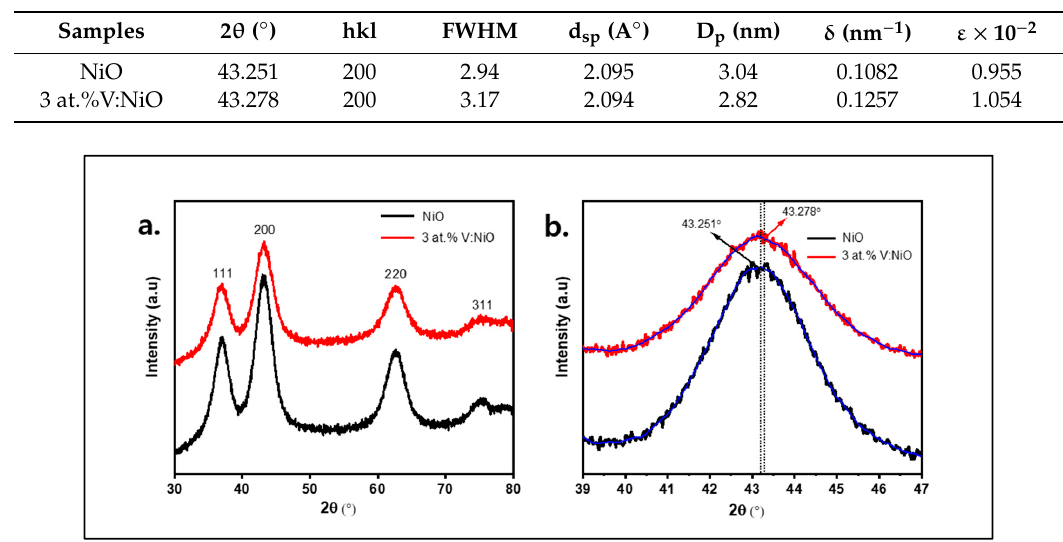
Figure 1. ( a ) XRD spectra of pristine and 3 at.%V:NiO nanoparticles (NPs) and ( b ) enlarged XRD spectra of pristine NiO and 3 at.%V:NiO NPs.